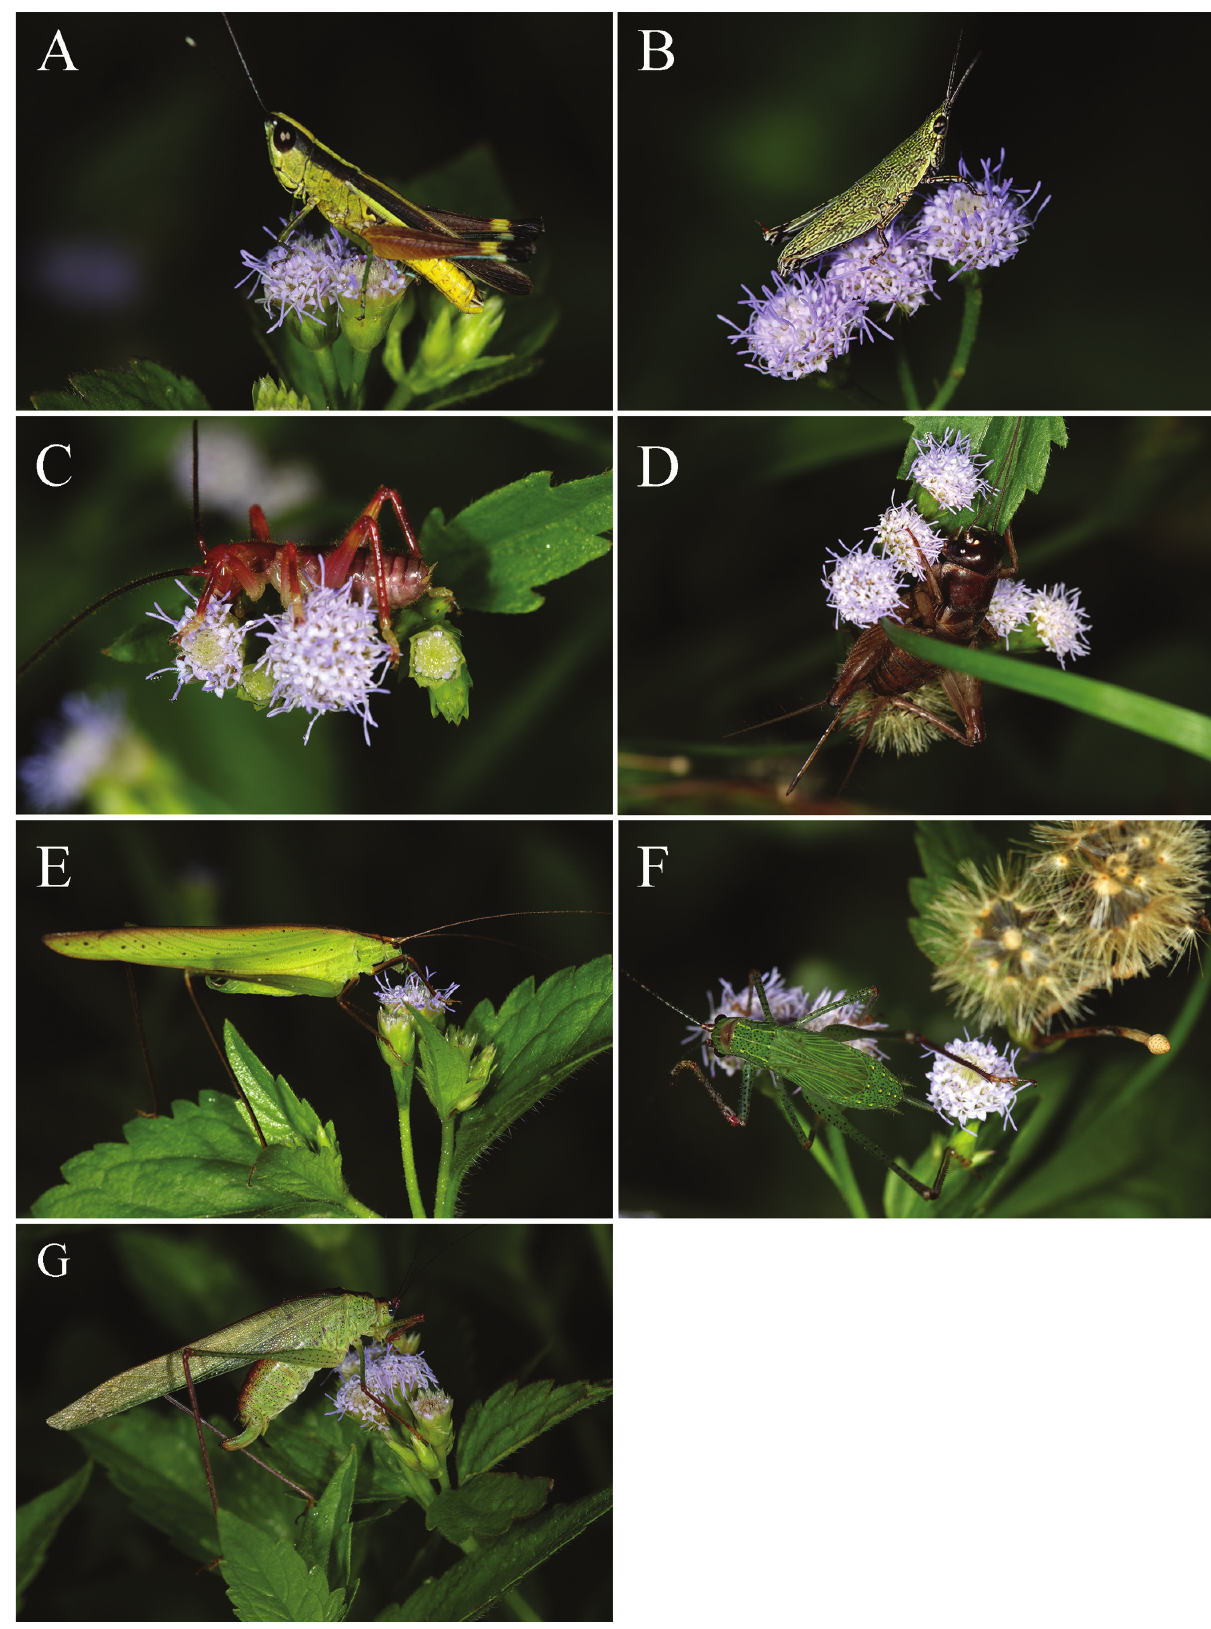
Fig. 6. Examples of flower-visiting orthopterans visiting weedy Praxelis clematidea in Sakaerat: A. Ceracris cf. fasciata , B. Chlorizeina cf. uni- color , C. Dialarnaca ? species, D. Velarifictorus ( Pseudocoiblemmus ) bilobus , E. Ducetia melodica , F . Paraducetia cruciata and G. Letana rubescens